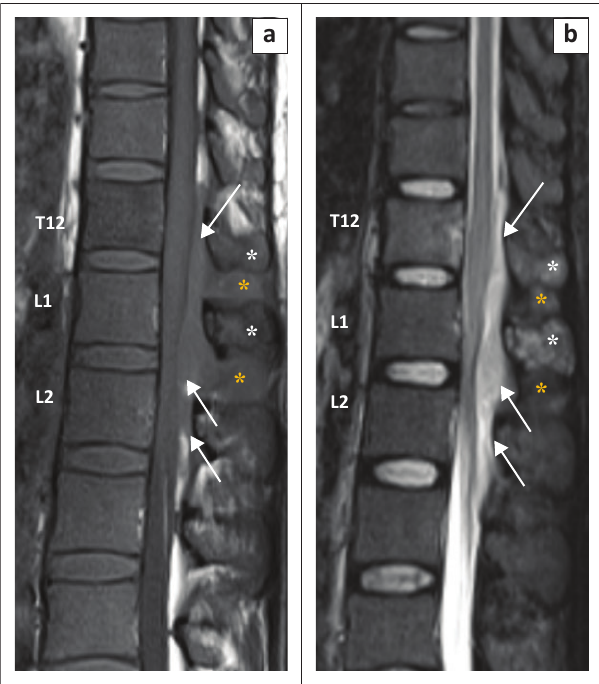
FIGURE 1: Sagittal T1W (a) and short tau inversion recovery (STIR) sequence (b) images reveal altered signal intensity involving the T12 vertebral body and spinous processes of the T12 and L1 vertebrae (white asterisks, a and b) which appear hypointense on T1W and hyperintense on STIR images. An ill-defined soft tissue mass of similar signal intensity is seen in the posterior epidural space extending from the T12 to L2 vertebral levels (arrows) with further extension into the interspinous soft tissue (yellow asterisks, a and b).